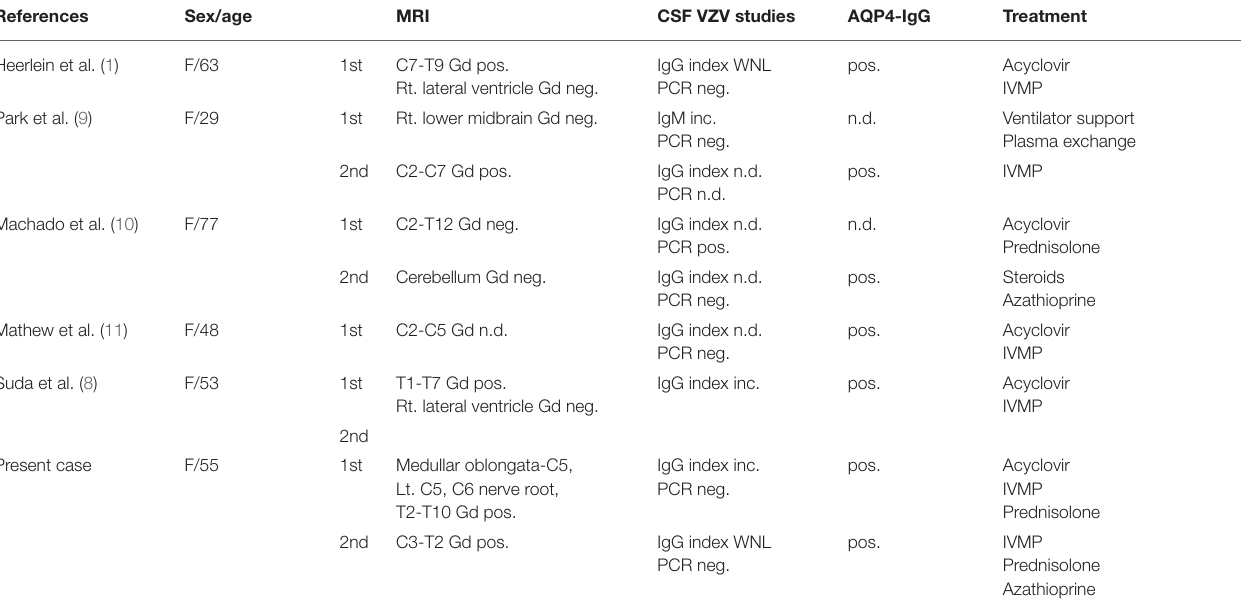
TABLE 1 | Clinical features of para varicella zoster virus associated myelitis with aquaporin-4 immunoglobulin G